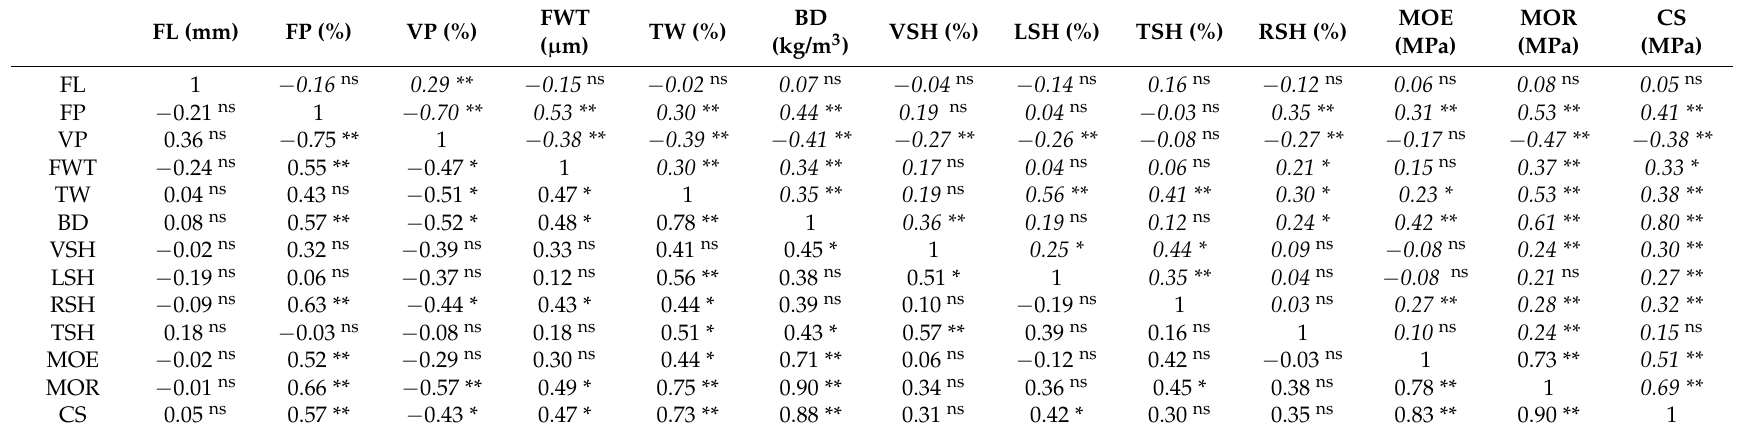
Table 5. Pearson correlation coefficients among the anatomical, physical, and mechanical properties of hybrid poplar clones. The upper right part ( in italic ) of the table presents the correlations among trees ( n = 105) and the lower left part indicates the correlations among clones within sites ( n =